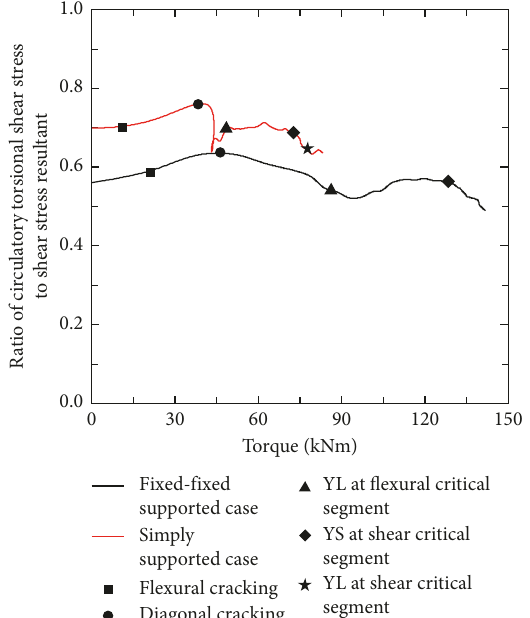
Figure 23: Ratio of circulatory torsional shear stress to the summation of shear